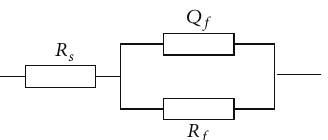
Figure3: Theequivalent circuit of electrochemical impedance spec- troscopy.